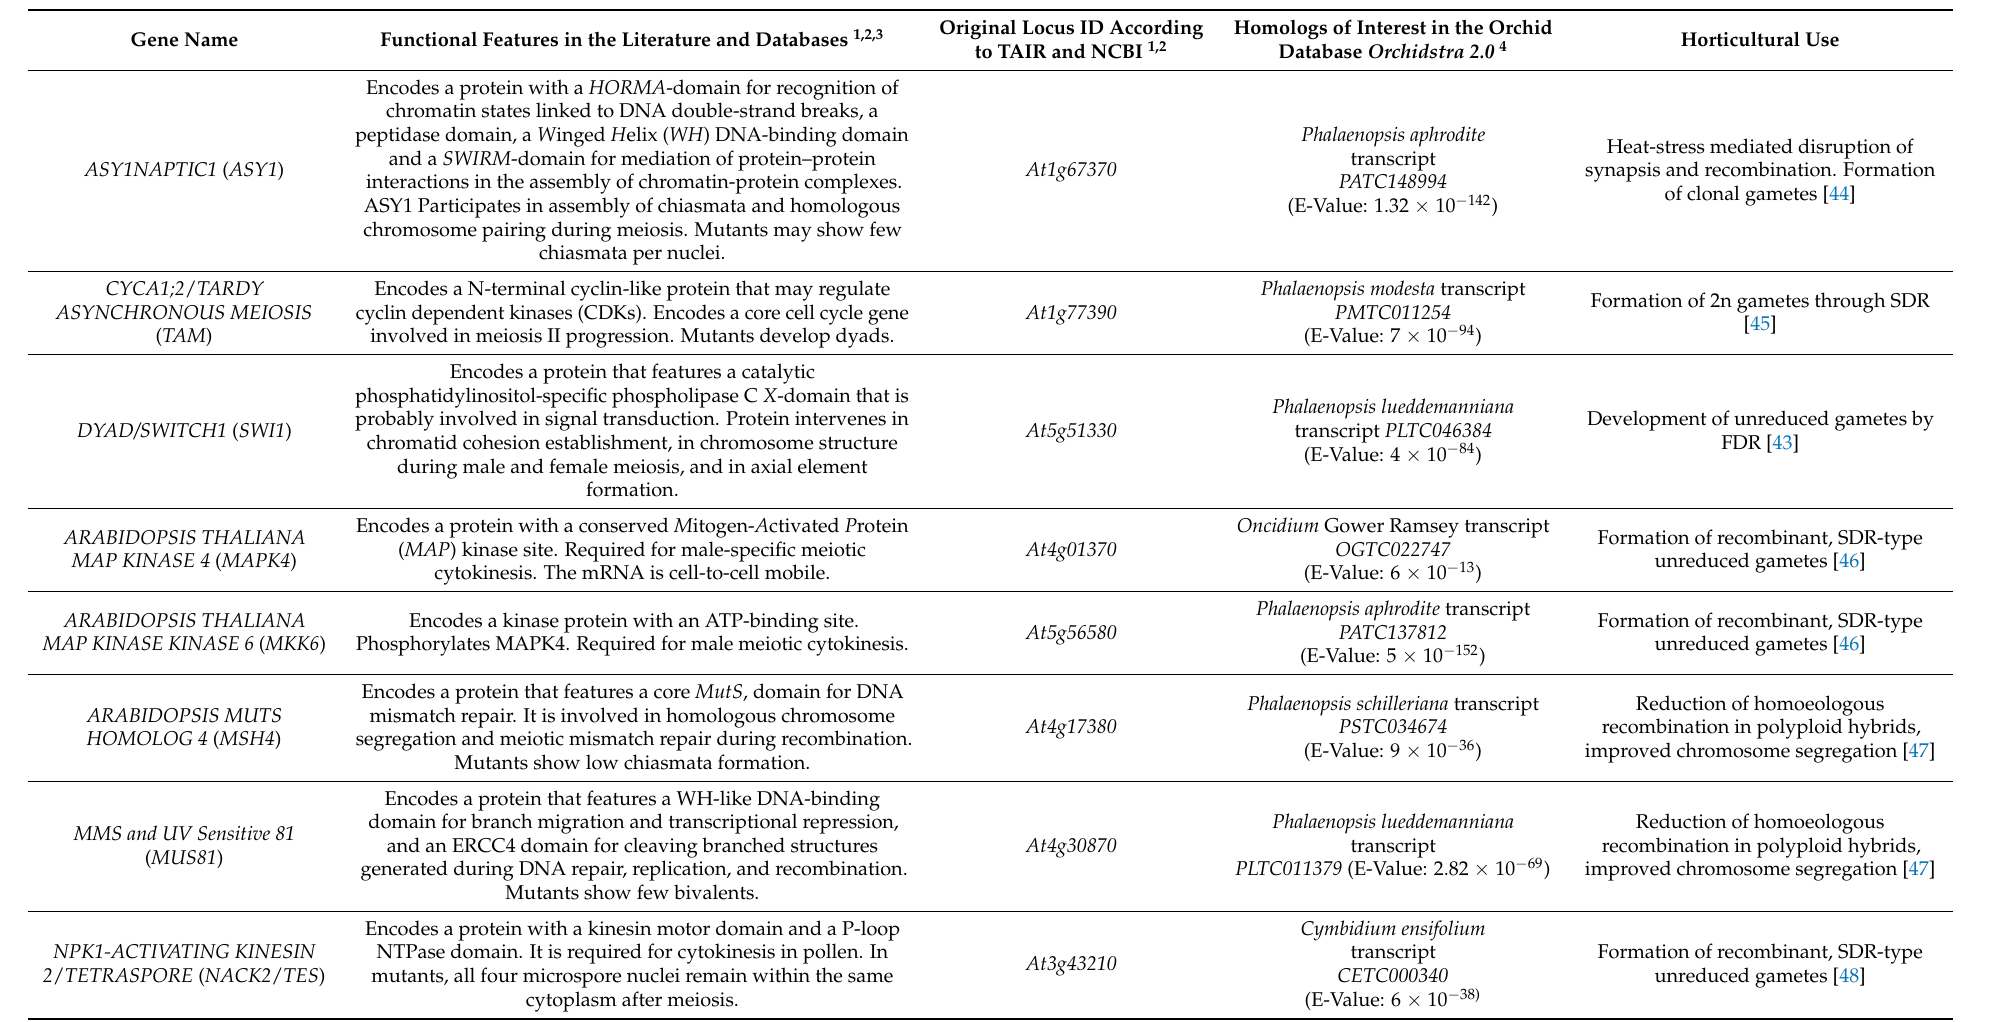
Table 2. Genes from model plant A. thaliana reportedly involved in meiotic restitution, crossover formation and chromatid alignment of interest for breeding polyploid orchid